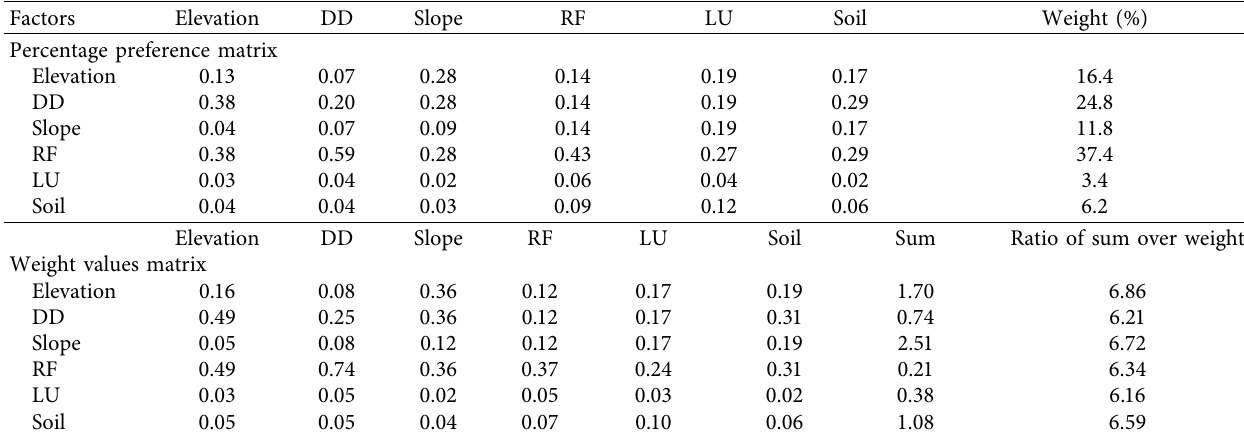
Table 4: Percentages of preferences and weight values’ matrixes.